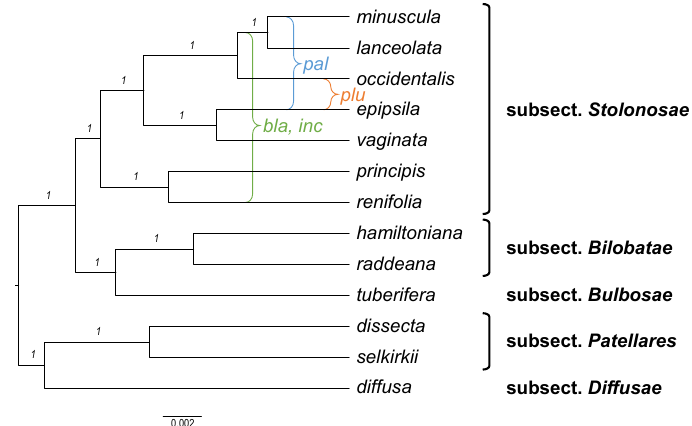
Figure 27. Phylogeny of Viola sect. Plagiostigma showing the delimitation of subsections (4 x ) with known allopolyploids (8 x ) superimposed, based on concatenated sequences of eight nuclear gene loci ( GPI-C , GPI-M , ITS-C , ITS-M , NRPD2a-C , NRPD2a-M , SDH-C , and SDH-M ). Outgroups have been pruned. The relative ages for polyploids are not to scale. Branch support is given as posterior probabilities. Abbreviations: bla, inc = V. blanda and V. incognita ; pal = V. palustris ; plu = V. pluviae . While 2 n = 24 is retained in most of the subsections, 2 n = 22 is apomorphic in subsect.